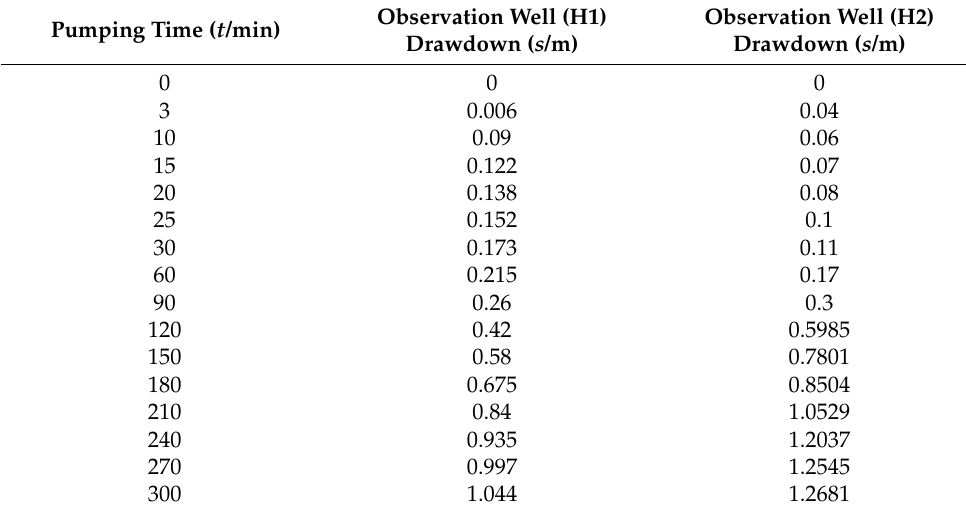
Table 1. Observation drawdown data during pumping.